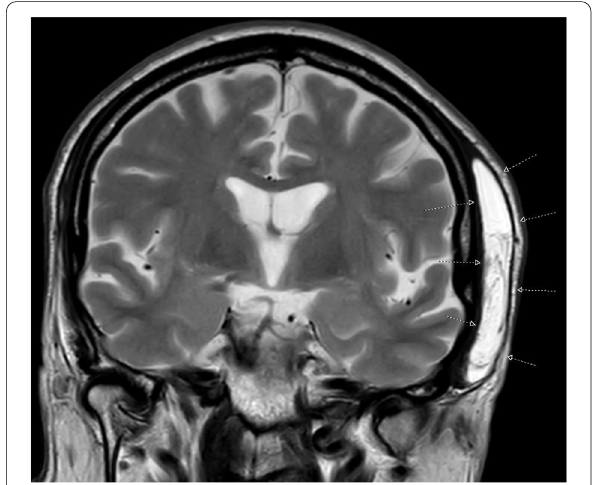
Fig. 3 Gross appearance of liposarcoma showing well-circumscribed mass with homogenous yellowish tissue (lipoma-like